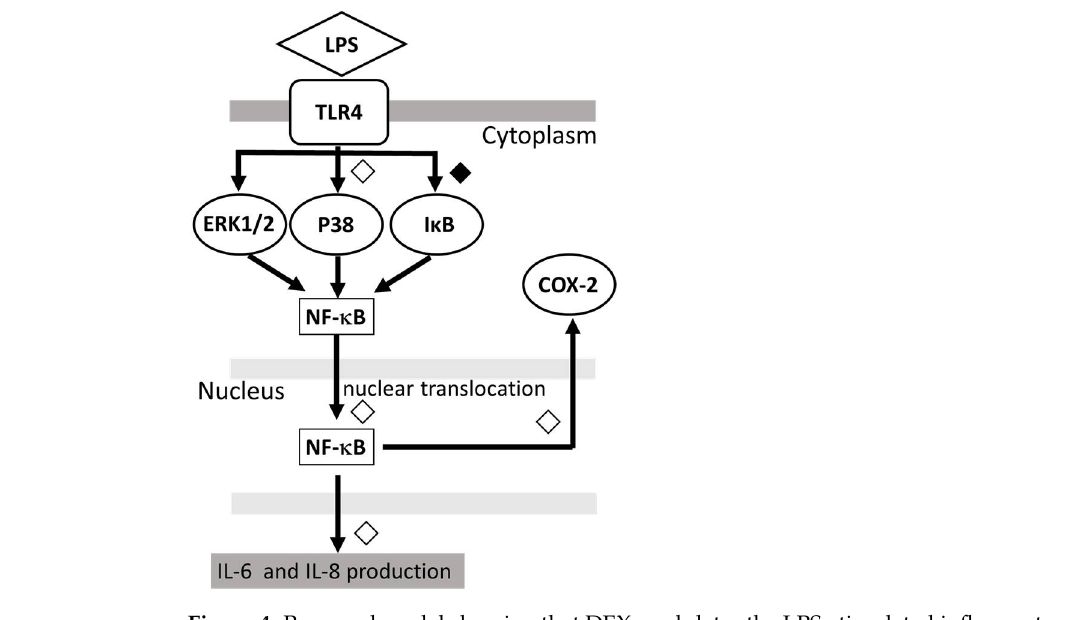
Figure 4. Proposed model showing that DEX modulates the LPS-stimulated inflammatory response. DEX suppressed the IL-6 and IL-8 production by LPS-stimulated HMC3 cells as well as the phos- phorylation of p38 MAPK and I κ B and the nuclear translocation of NF- B. ; partial inhibition: ; significant inhibition.